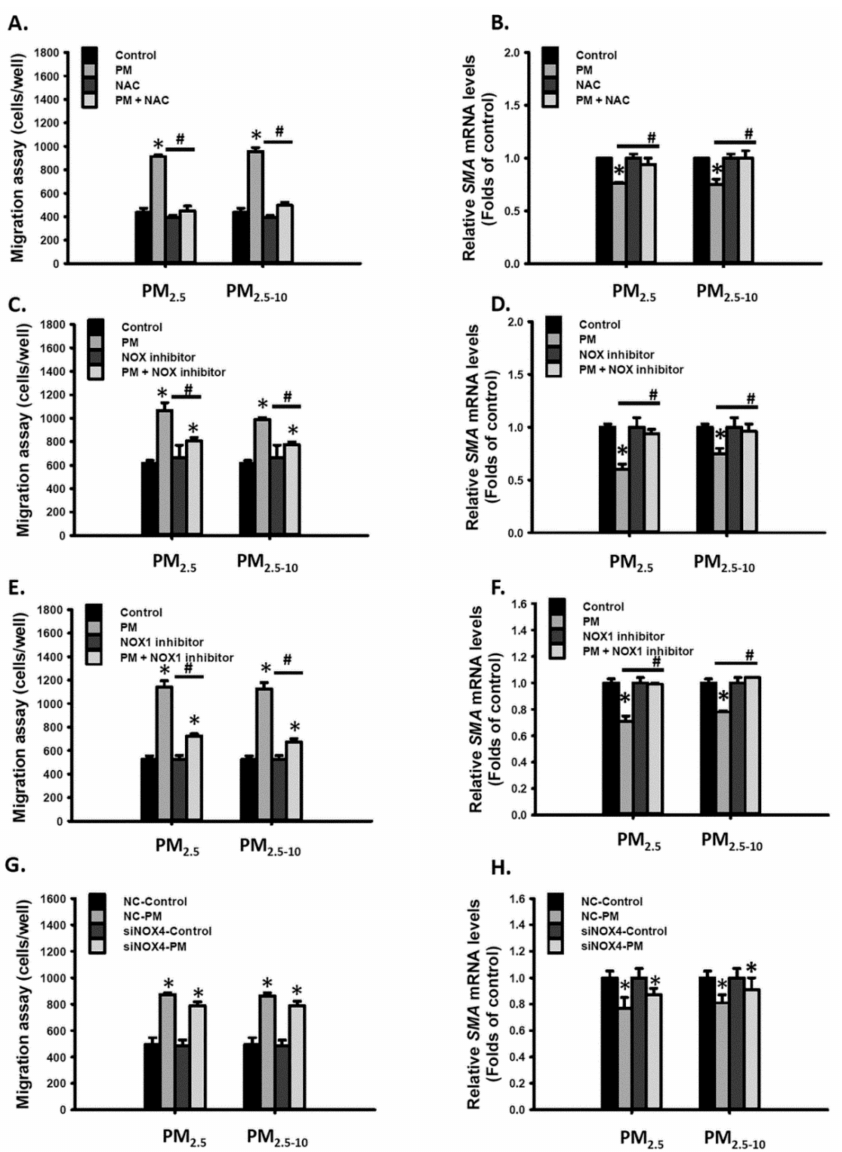
Figure 4. PM 2.5 and PM 2.5-10 induced cell migration via the NOX1-ROS signaling pathway in MVSMCs. MVSMCs were treated with d 2 H 2 O or 25 µ g/mL PM 2.5 or PM 2.5-10 with and without 10 µ M NAC for 48 h. ( A ) Cell migration ability and ( B ) relative SMA mRNA levels were determined. MVSMCs were treated with d 2 H 2 O or 25 µ g/mL PM 2.5 or PM 2.5-10 with and without 10 µ M NOX inhibitor for 48 h. ( C ) Cell migration ability and ( D ) relative SMA mRNA levels were determined. MVSMCs were treated with d 2 H 2 O or 25 µ g/mL PM 2.5 or PM 2.5-10 with and without 10 µ M NOX1 inhibitor for 48 h. ( E ) Cell migration ability and ( F ) relative SMA mRNA levels were determined. NC-MVSMCs and siNOX4- MVSMCs were treated with d 2 H 2 O or 12.5 µ g/mL PM 2.5 or PM 2.5-10 for 48 h. ( G ) Cell migration ability and ( H ) relative SMA mRNA levels were determined. The results are presented as the mean ± SD for three or three independent experiments. * p < 0.05, compared with vehicle-treated cells. # p < 0.05, compared with inhibitor-treated cells. Con: vehicle treatment as control; NC: negative control for